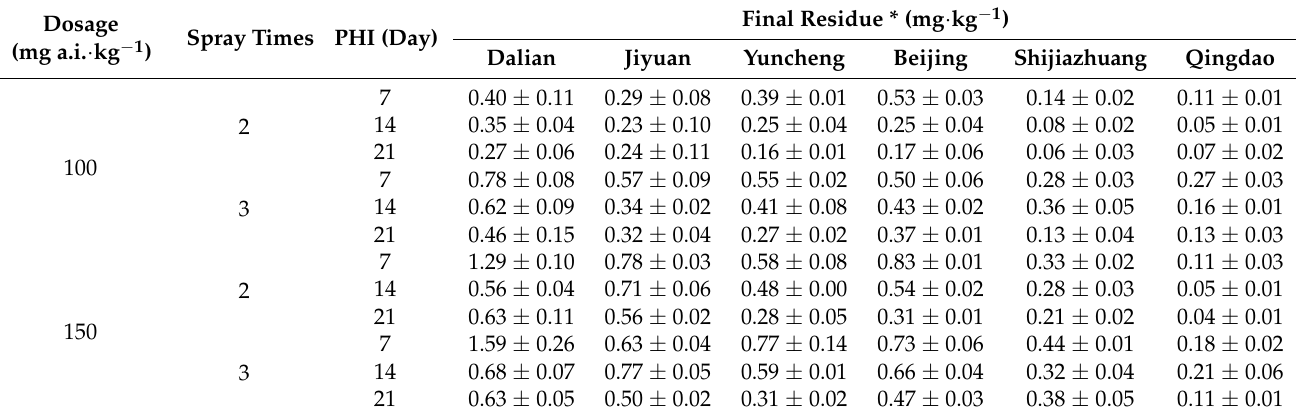
Table 3. Final residue data of difenoconazole on jujube ( n = 3).